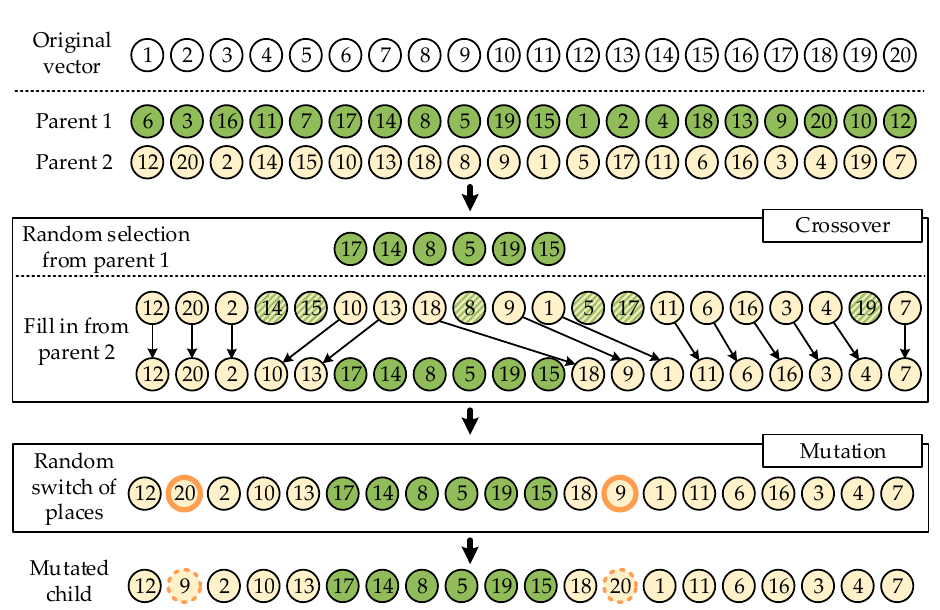
Figure 7. Genetic algorithm crossover and mutation examples for 20-element vectors.